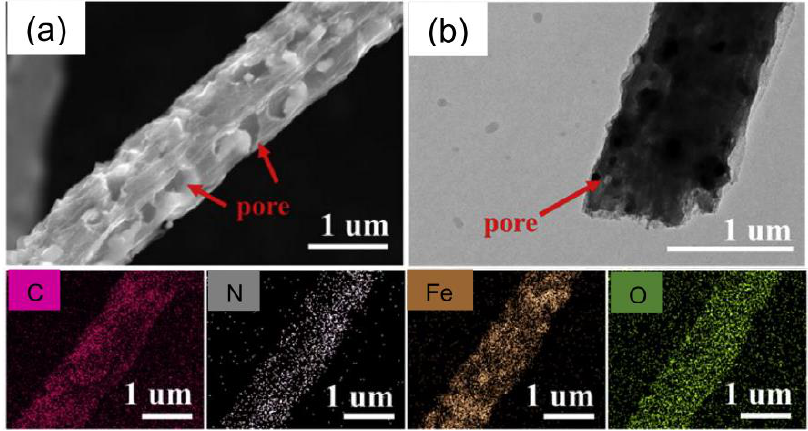
Figure 13. ( a ) SEM and ( b ) TEM images of the composite γ -Fe 2 O 3 /C fibers, with elemental mapping at the bottom (reproduced from reference [136] with permission. Copyright 2018, Elsevier).